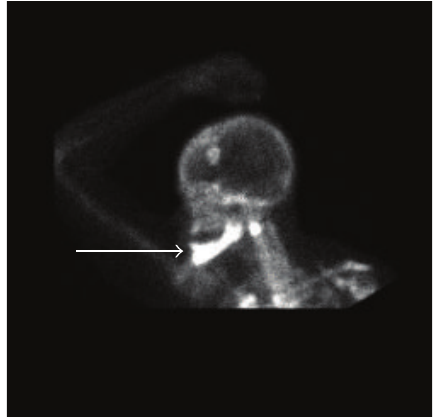
Figure 4: Repeat Technetium 99m bone scintigraphy. Progres- sion of diffuse intense bony radioactivity involving most of the mandible, most likely related to diphosphonate induced mandibular